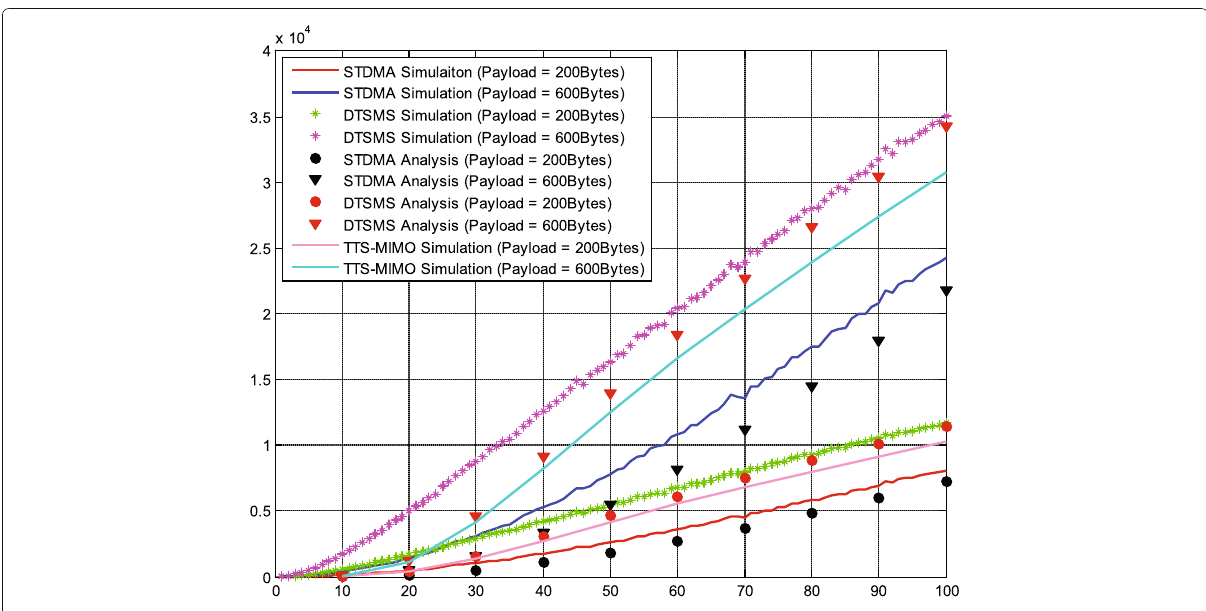
Fig. 9 Throughput with different traffic arrival rates